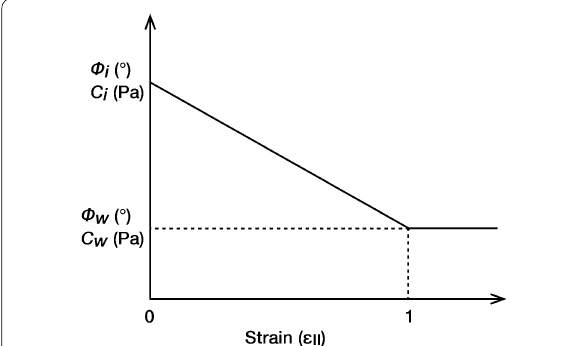
Fig. 5 Strain weakening behavior of material. Strain weakening is initiated after an accumulated strain ε II cohesion ( φ i , C i ) both linearly decrease between ε II the weakened values ( φ w , C w ), which they